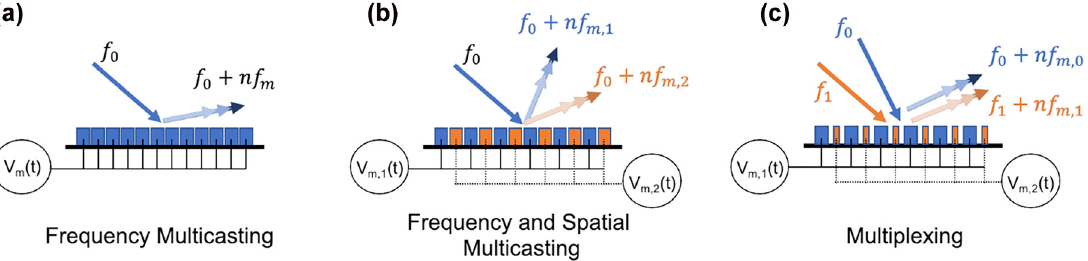
Figure 5: Multicasting and multiplexing schemes achievable with a space-time metasurface illuminated with optical frequencies and ( t ) denotes a time-varying voltage of frequency f applied to the metasurface, f is the modulated with RF signals. In all schematics, V 0 m m frequency of light incident on the metasurface, and the output light is a sum of the incident frequency with integer multiples of the modulating frequency. (a) A single input is converted to multiple frequencies and steered to a given angle. (b) A single input frequency incident on a space-time metasurface driven with two waveforms of differing frequency and spatial phase gradient. This results in two spatially tunable beams, each consisting of a different spectrum of harmonics. (c) A space-time metasurface consisting of two alternating elements with different resonant frequencies. This allows two input frequencies to be individually steered, while controlling the harmonic content of each